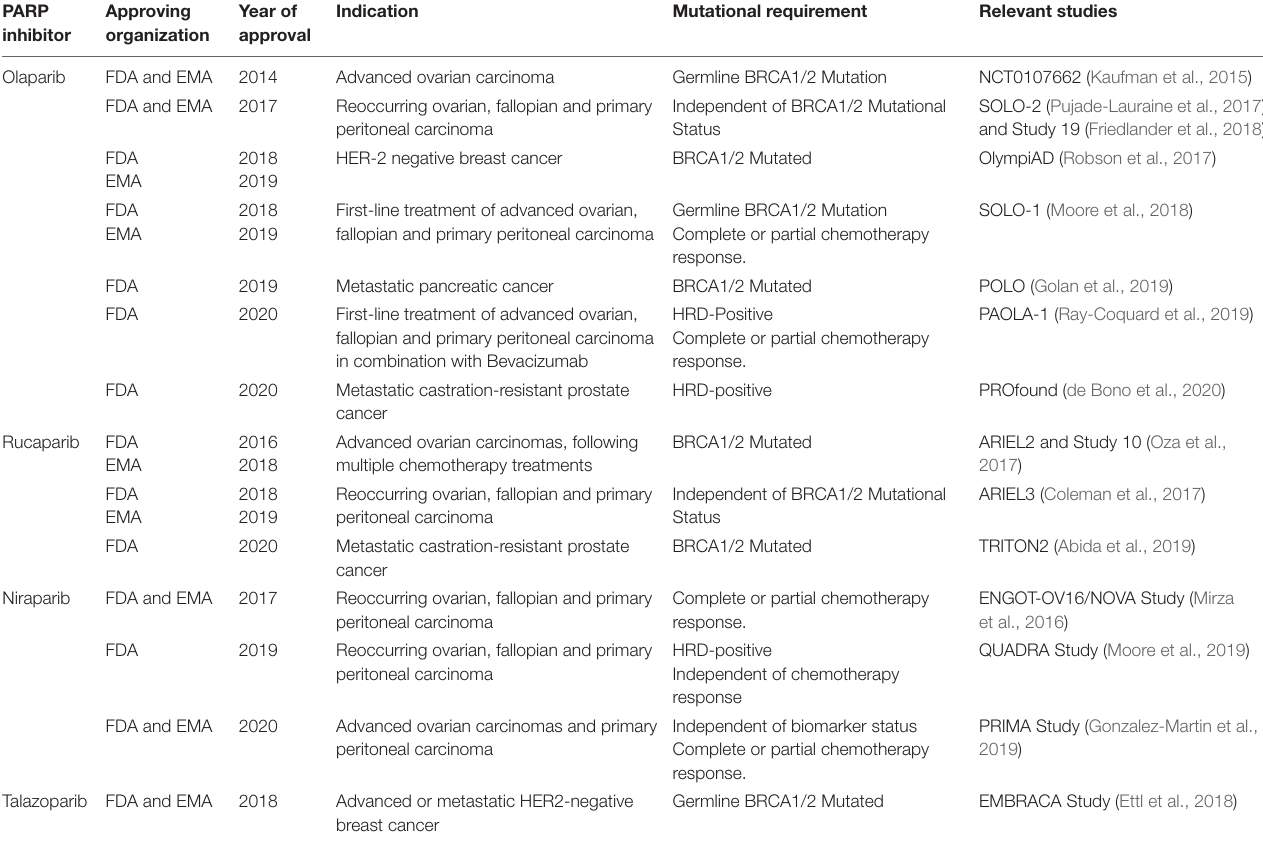
TABLE 1 | Food and Drug Administration (FDA) and European Medicines Agency (EMA) approval history of PARP